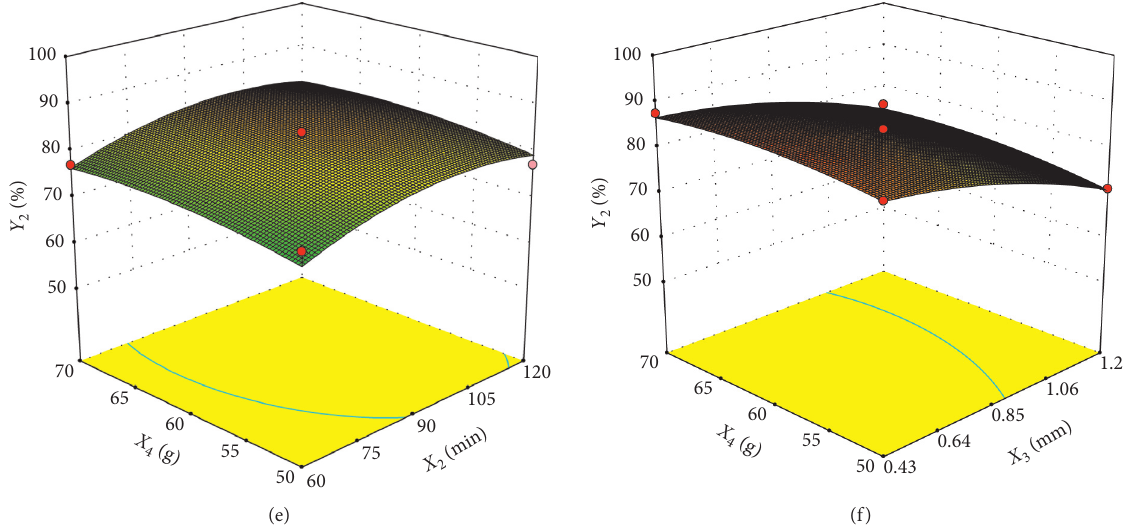
� 0.85mm, X � 60g. (b) X � 90min, 3 4 2